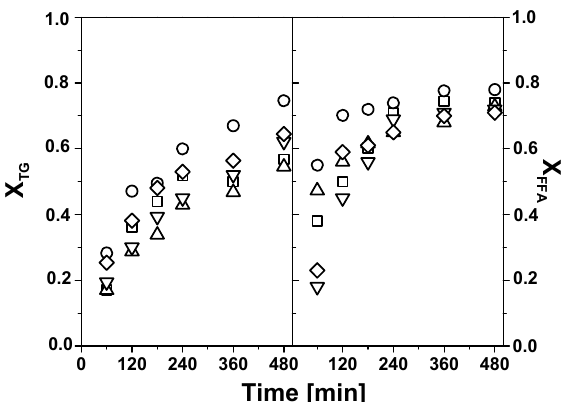
Figure 7. Evolution with reaction time of the conversion of triglycerides (X TG ) and FFAs (X FFA ) for supported s-Mo (6) (squares); s-Mo (8) (circles); s-Mo (10) (triangles); s-Mo (13) (inverted triangles); s-Mo (16) (rhombus) catalysts. Reaction conditions: 100 ◦ C, 30 atm, methanol / feedstock molar ratio of 12:1, 2 wt.% catalyst referred to the feedstock mass. Feedstock: refined sunflower oil containing 5 wt.% free oleic acid.